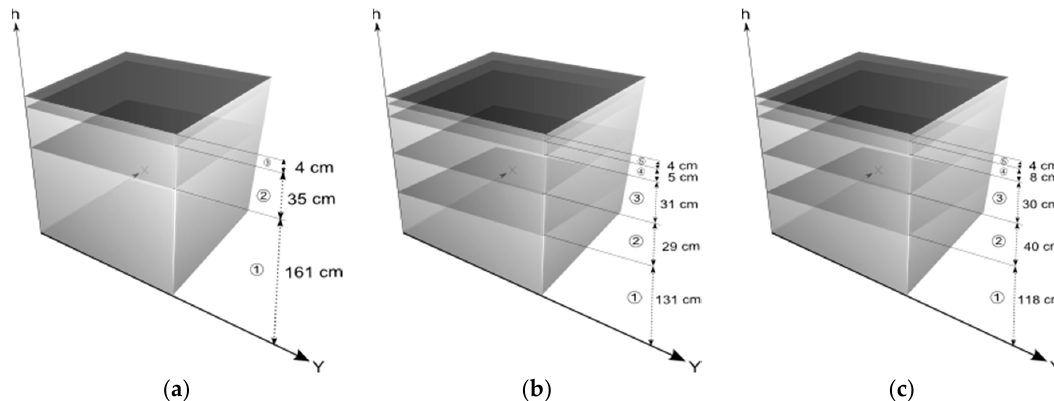
Figure 2. Sketch of the thickness of real urban testing pools layers. ( a ) Pool 1: pedestrian pavement